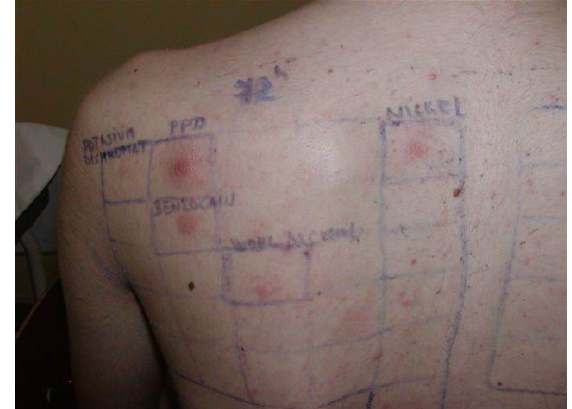
Figure 4. Positive patch test with PPD, benzocaine, wool alcohols, nickel sulphate, and potassium